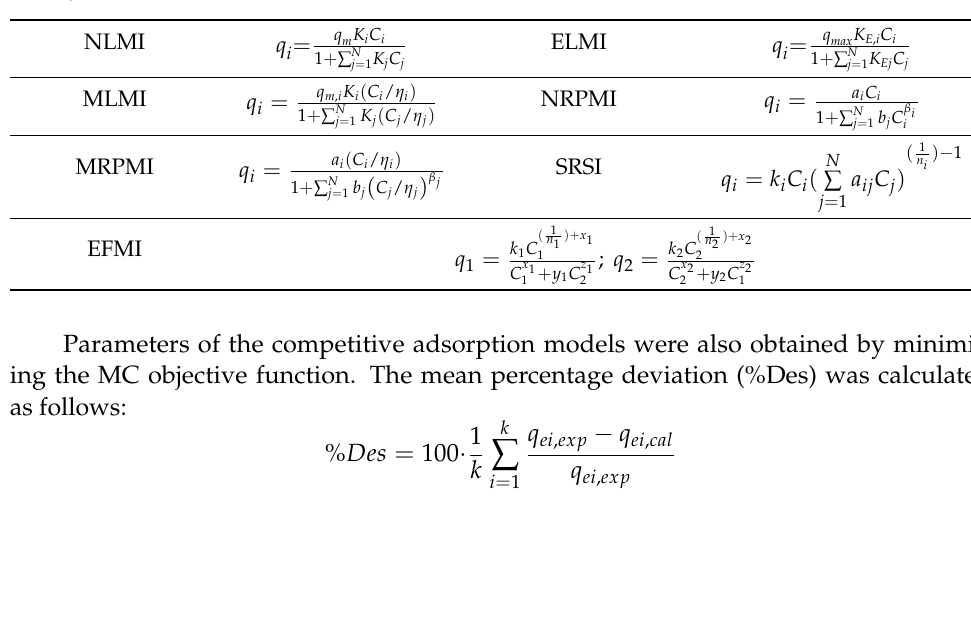
Table 2. Equations for the isotherm models used to describe experimental data in multicompo- nent